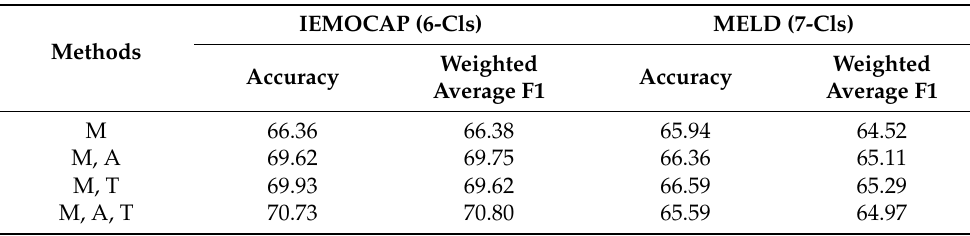
Table 3. Results for multimodal sentiment analysis with different tasks using MLMF. “M” is the main task, and “A, T” are auxiliary tasks. Only the results of task “M” are reported. IEMOCAP (6-Cls) MELD Methods